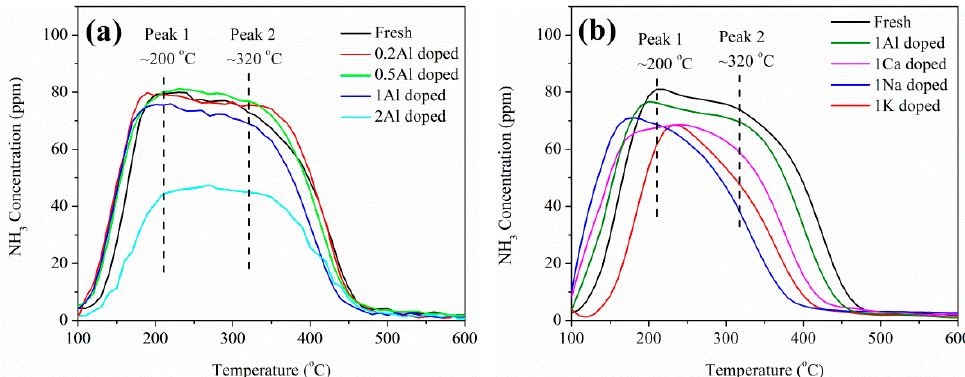
Figure 6. NH 3 -Temperature Programmed Desorption (TPD) profiles of various catalysts: ( a ) fresh (1V-5W/Ti) and Al doped catalysts with different Al/V molar ratios, and ( b ) fresh and 1 M doped catalysts (M = Al, Ca, Na, and K).